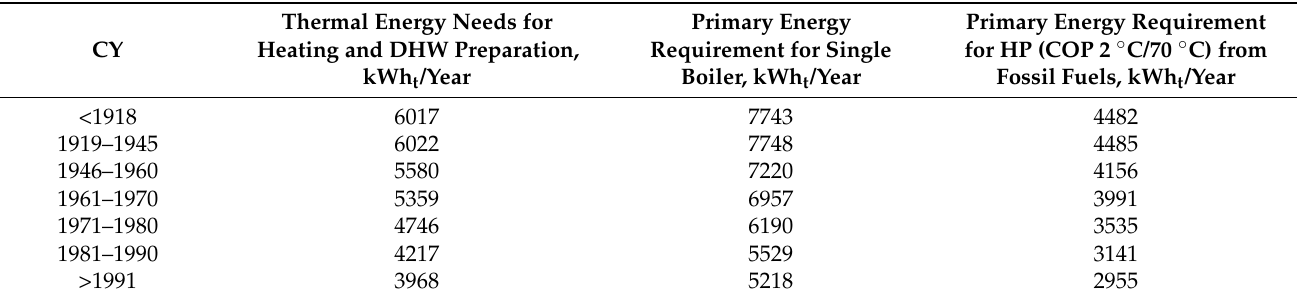
Table 6. Total heating needs and primary energy requirements for boilers ( η h = 0.8; η w = 0.7) and selected HPs, per building construction year CY in the city of Salerno (generation fraction from RES 35%, grid losses 10%, COP at design temperature of 2 ◦ C).